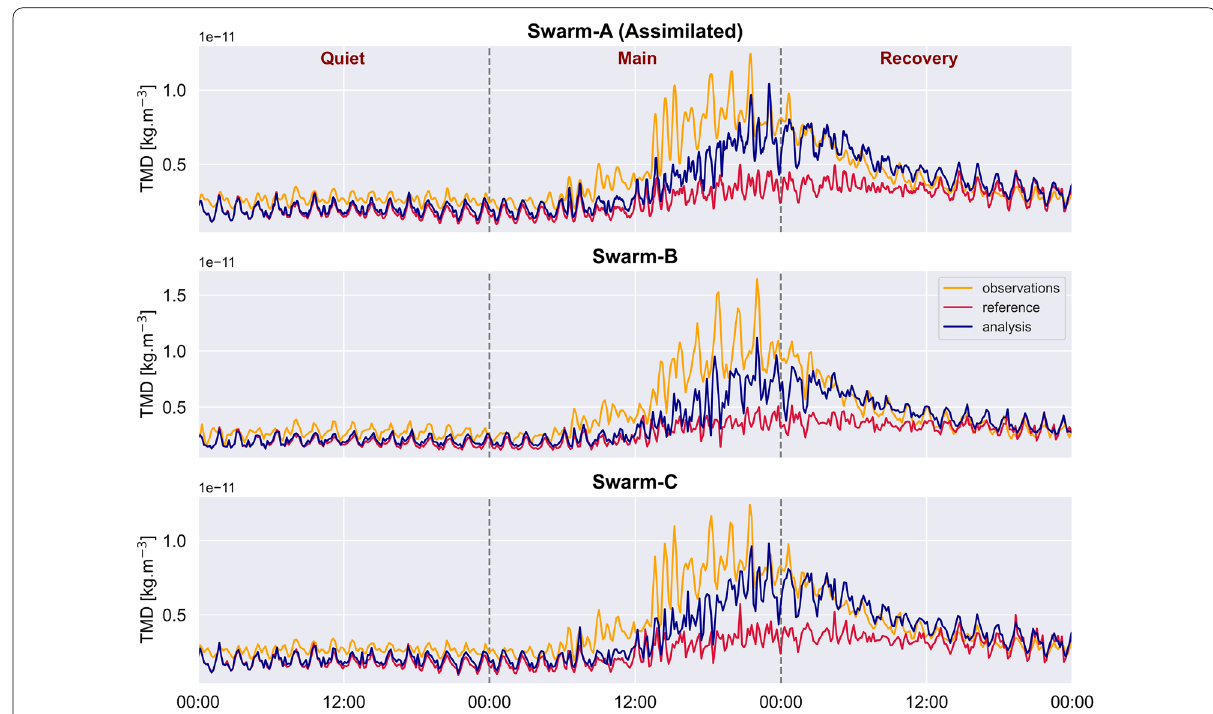
Fig. 2 Results of TMD normalized to 400km for Swarm‑A (assimilated) and Swarm‑B/C (validation). Observations (yellow), reference run (red) and analysis (blue) are shown for the 3 days 16–18 March 2015. The differences between reference and analysis during the main and recovery phases show the effect of data assimilation along the orbit of Swarm satellites. Differences up to 2 × 10 − 12 kg.m − 3 are found during the peak of the storm